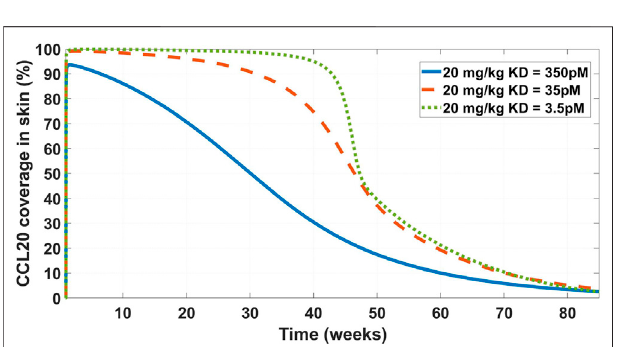
FIGURE 6 | Model projected CCL20 coverage in the skin after administration of 20 mg/kg IV bolus dose ofGSK3050002. Three mAb af fi nity scenarios were modeled – 350 pM (solid blue line), 35 pM (dashed orange line), and 3.5 pM (dotted green line). The low coverage at the base K D of 350 pM is consistent with observed lack of activity as described in Bouma et al.